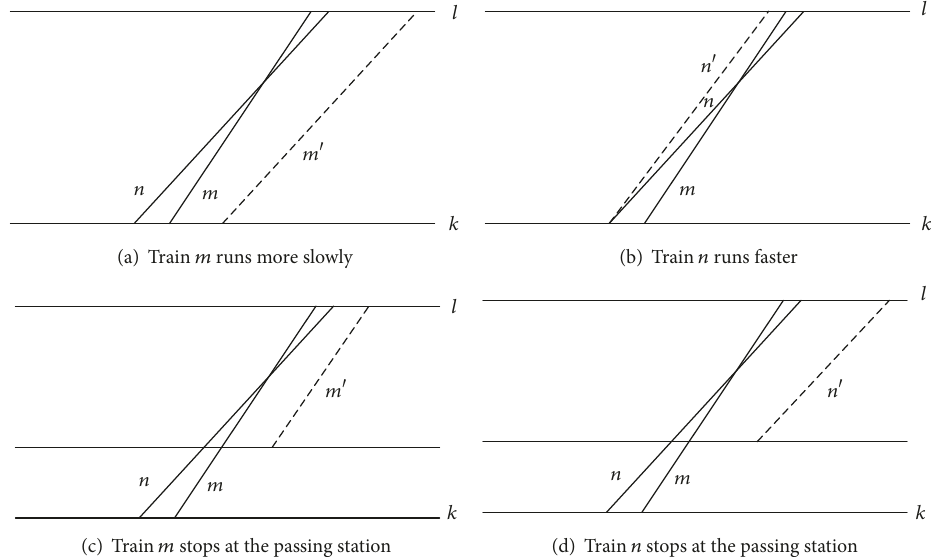
Figure 2: Section conflict and